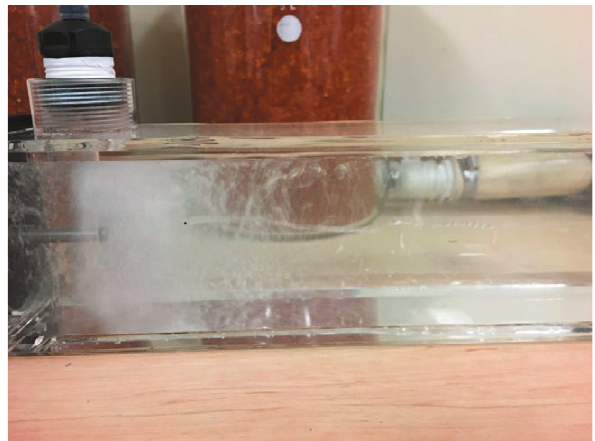
Figure 6. Photograph of the propeller used to study cavitation at the laboratory scale.